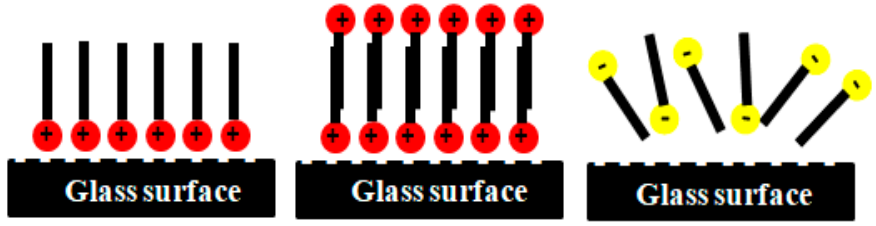
Figure 7. Adsorption conformations of DTAB and SDS on glass surface. The red ball represents the head group of DTAB and the yellow ball represents the head group of SDS.